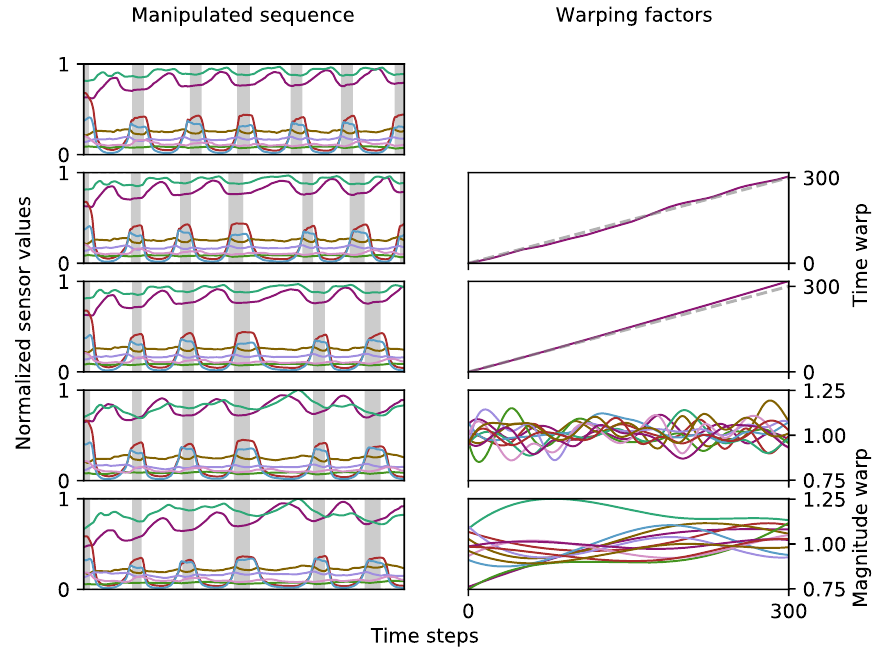
Figure 7. The process of applying multiple label preserving warps to the same sequence. The gray areas on the left denote breaks between exercise repetitions. For time warp a polynomial is accumulated and interpreted as time intervals to modify all sensor